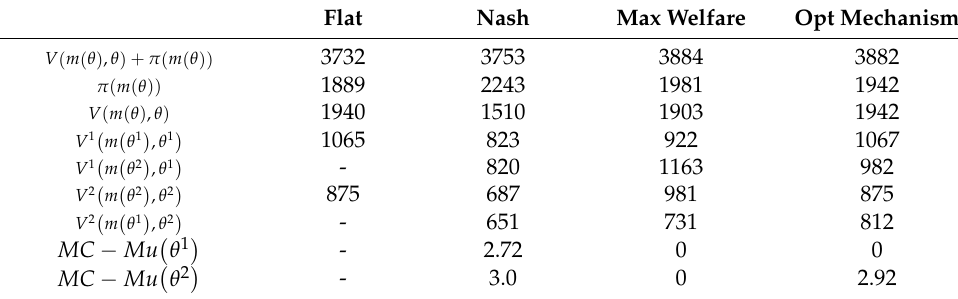
Figure 7. The optimal mechanism pricing. The optimal load ( a ) and prices ( b ). Table 2. Characteristics of equilibria with different pricing schemes,